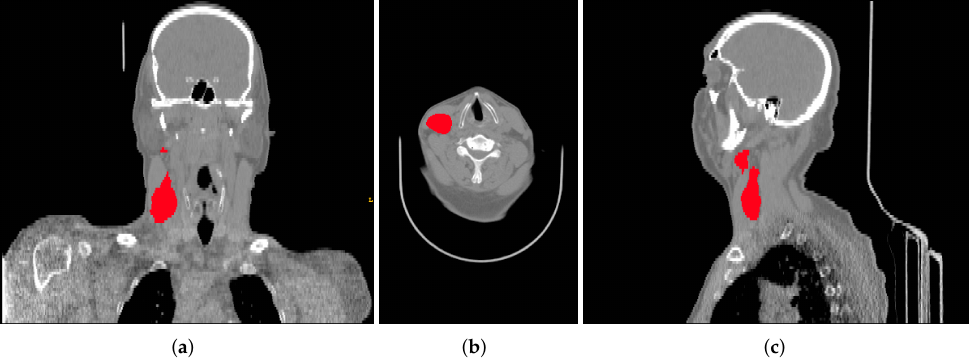
Figure 2. Example of a CT scan from the data collection with the corresponding segmentation of the gross tumour volume, shown in all three planes: ( a ) coronal, ( b ) axial, and ( c )